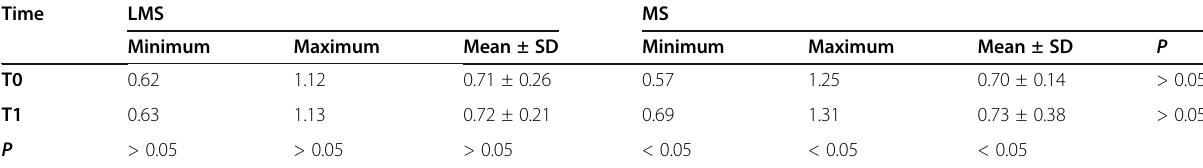
Table 5 Comparison of the level of tumor necrosis factor (TNF)- α (pg/mL) detected in the LMS and MS groups Time LMS